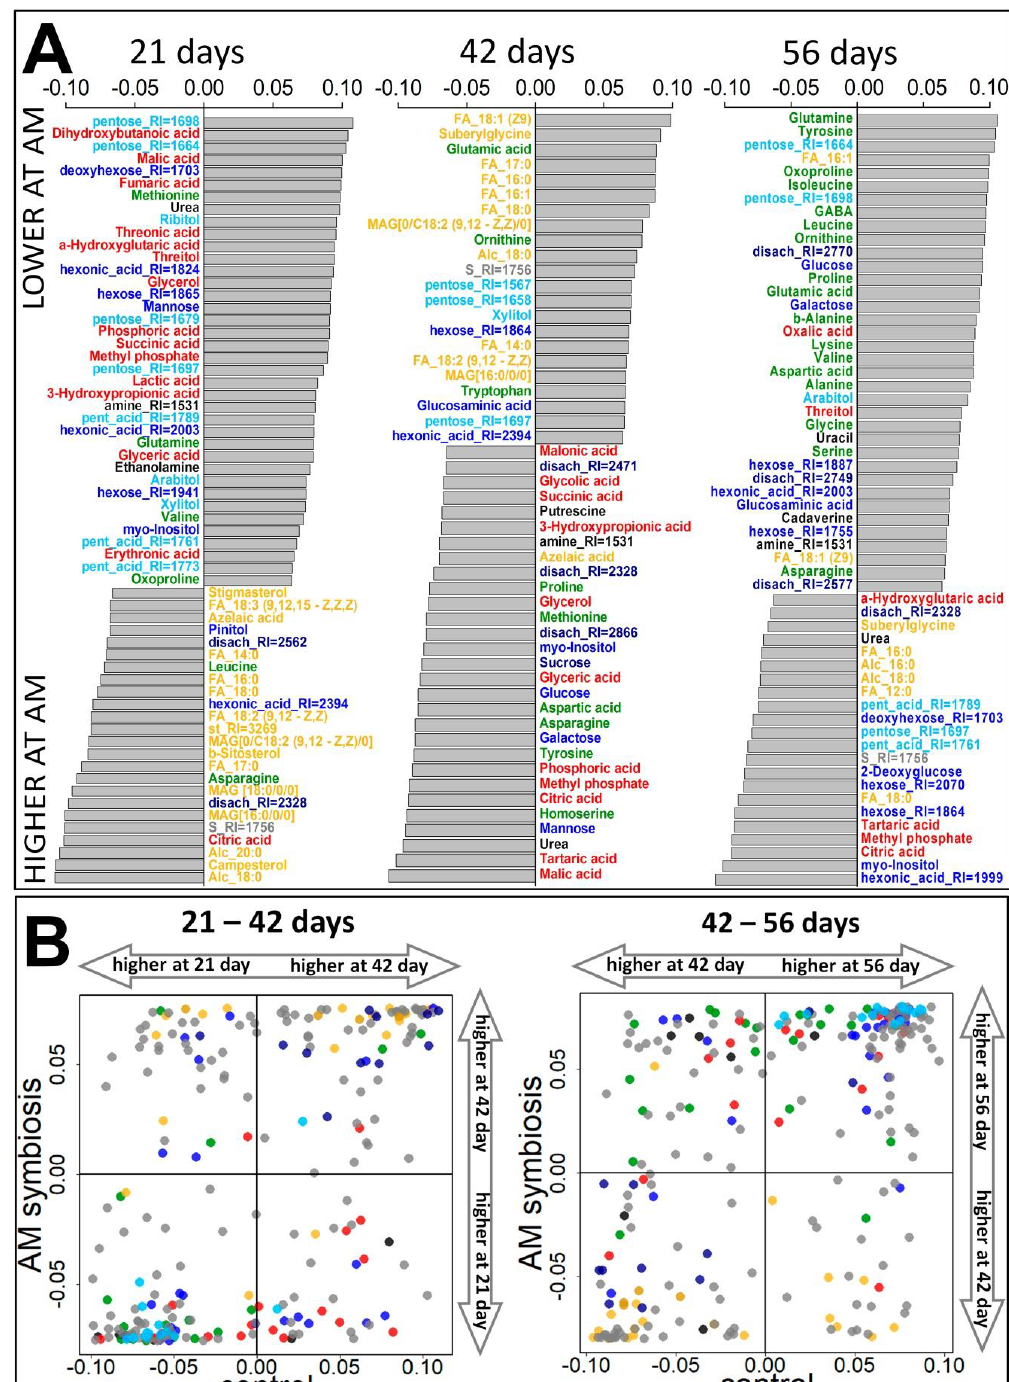
Figure 4. Influence of mycorrhiza on the metabolome of pea cv. Finale roots sampled at 21, 42, and 56 day. ( A ) Barplots of the loadings of predictive components (VIP > 1) from OPLS-DA models for comparison of control and mycorrhized roots, positive values correspond to a higher content during mycorrhization. ( B ) Influence of mycorrhiza on the metabolome dynamics. Metabolites scattering in the space of the loadings from OPLS-DA models for comparing adjacent time points under control (abscissa) and mycorrhization (ordinate). Color code is the same as in Figure 3.